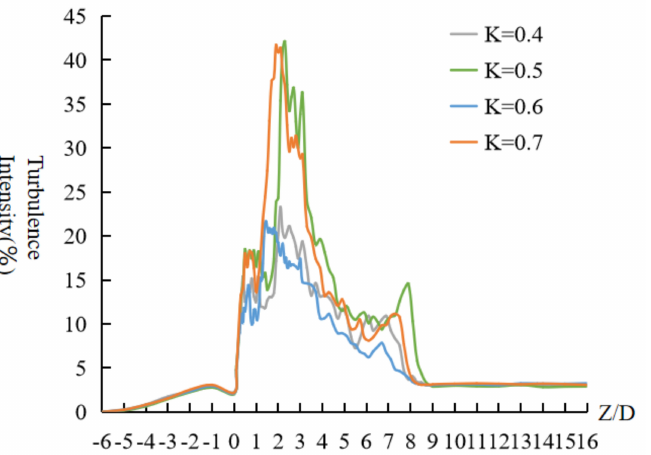
Figure 13. Variation trend of cross-sectional average turbulence intensity along the flow direction.